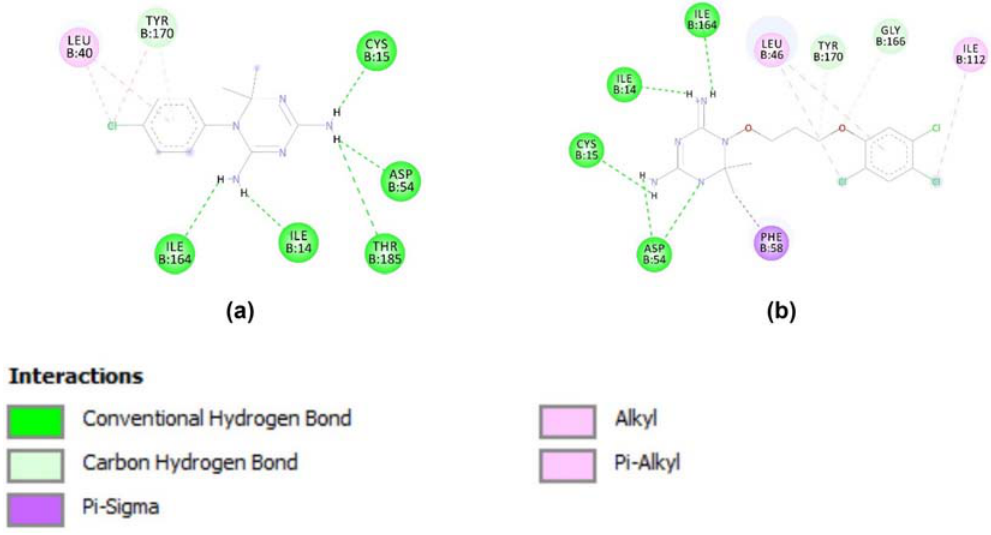
Figure 1: Hydrogen bonding patterns of cycloguanil and WR99210 inhibitors with enzyme pfDHFR - TS ( PDB ID: 1J3I ) . ( a ) Cycloguanil and ( b )